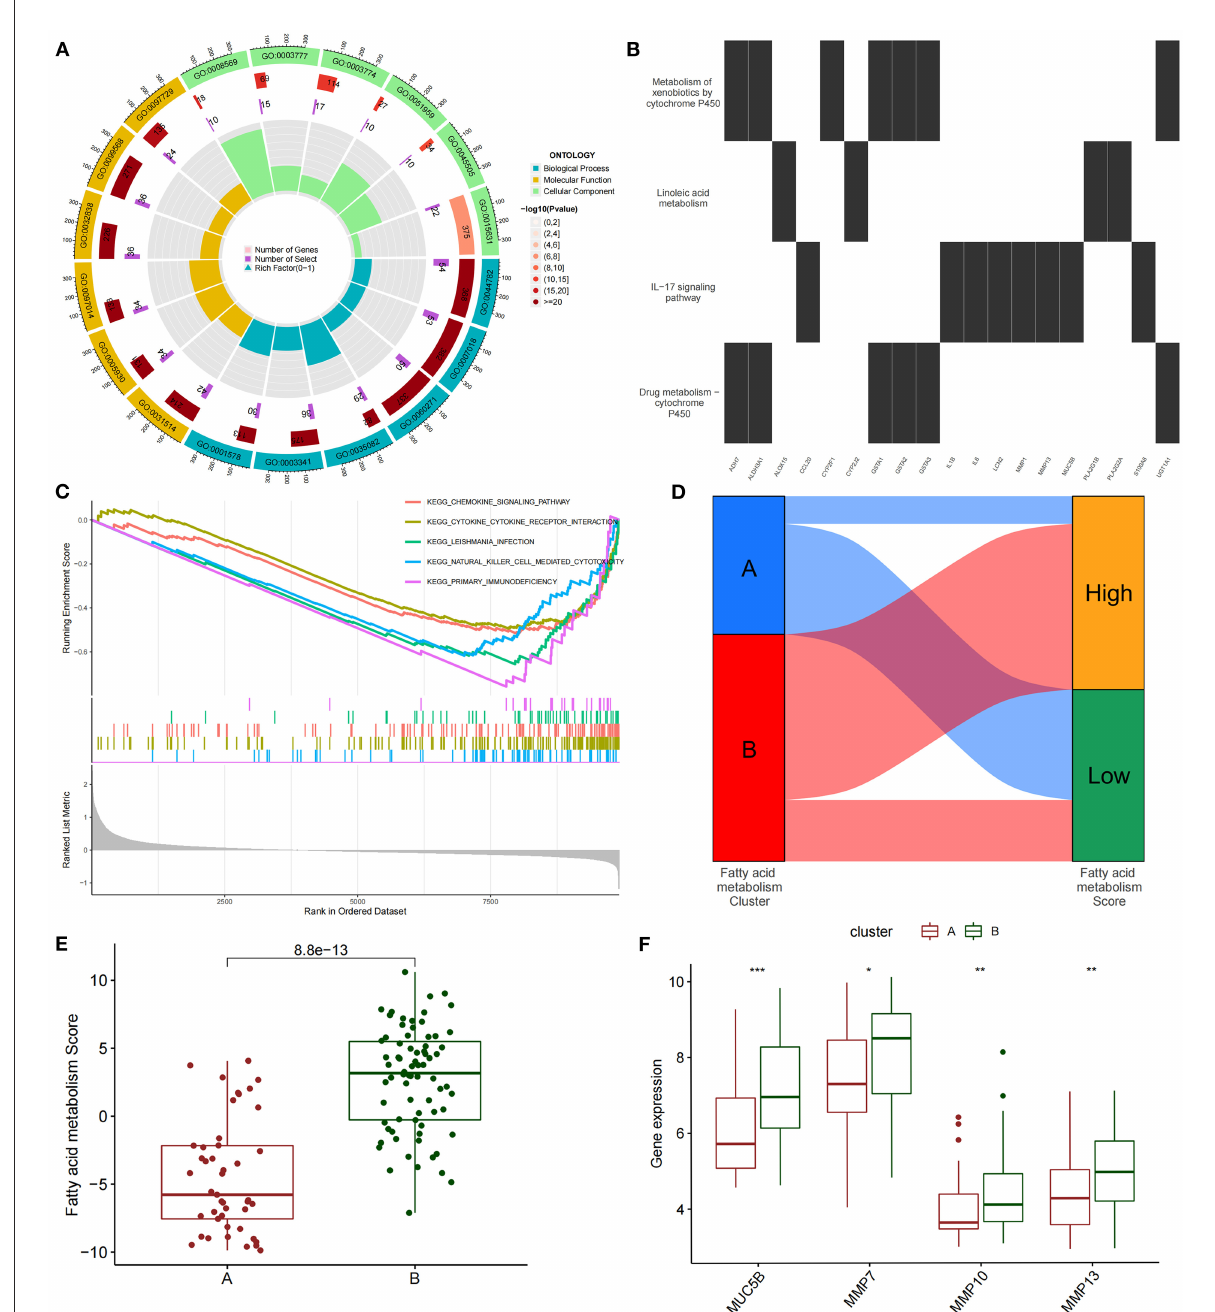
FIGURE2 By unsupervised clustering of 24 FAMRGs, two different subtypes were identified in IPF. (A) GO analysis of differentially expressed genes between subtypes reveals related biological processes, molecular functions, and cellular components. (B) KEGG enrichment analysis of differentially expressed genes among subtypes. (C) GSEA analysis of key differential pathways among subtypes. (D) Distribution proportion of fatty acid metabolism in samples of different subtypes. (E) Differences in fatty acid metabolism between subtypes. (F) Differences in the expression levels of fibrosis-related biomarkers among subtypes. * P < 0.05, ** P < 0.01, *** P < 0.001.